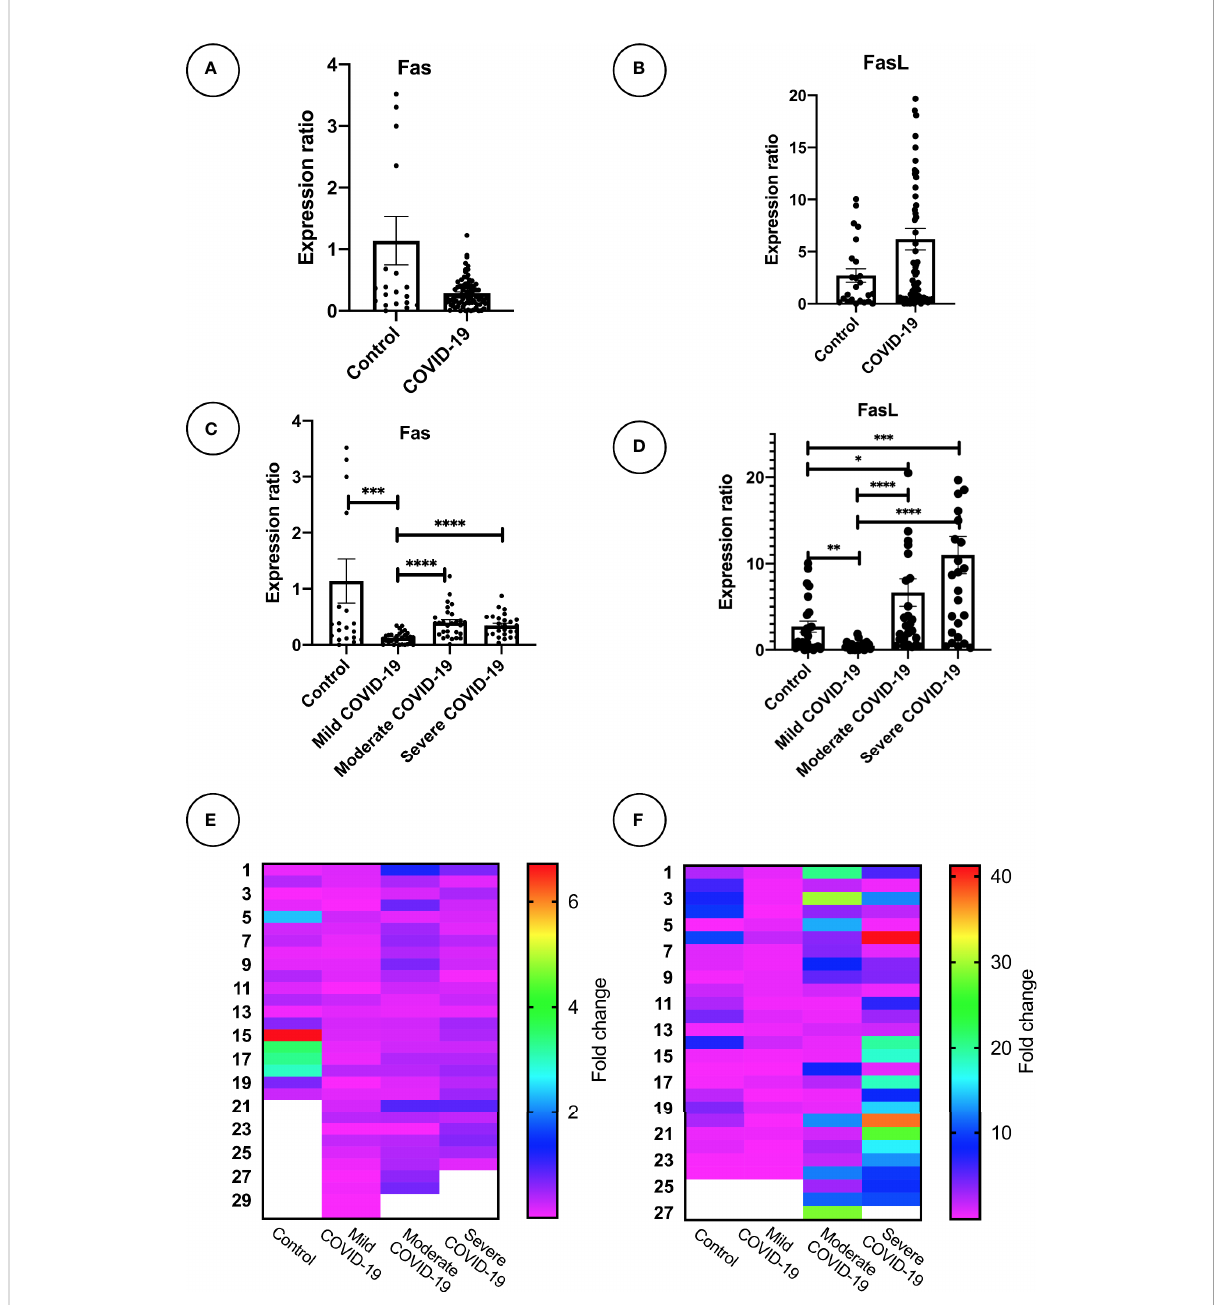
FIGURE 1 Fas and FasL mRNA expression in PBMC samples mRNA expression of Fas and FasL is shown for (A, B) COVID-19 (n = 93) and control group (n = 27). (C, D) , mild, moderate, and severe COVID-19 (n = 31 per group), and control group (n = 27). (E, F) Heatmaps graphically